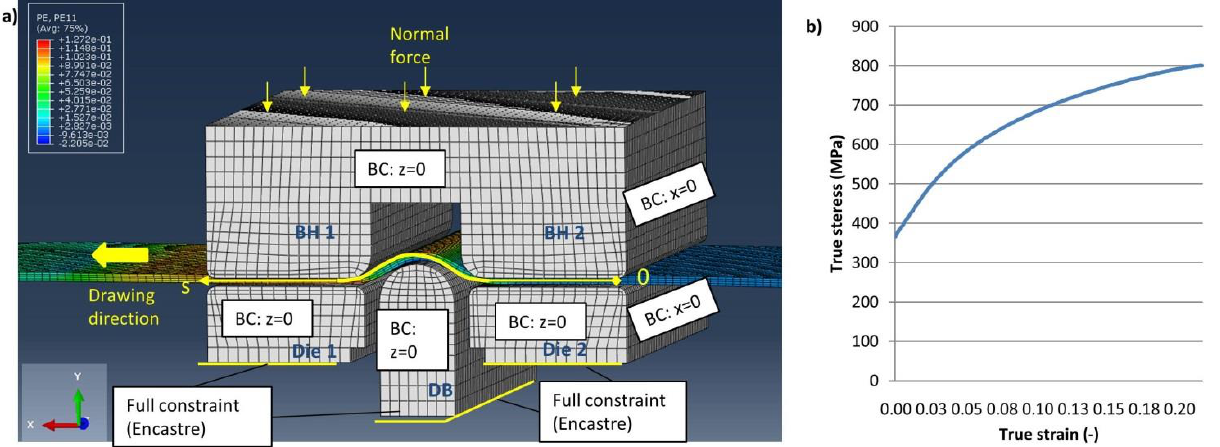
Figure 21. ( a ) Three-dimensional model for calculating the strain distribution in the wear test with draw bead geometry with boundary conditions (after drawing the sheet 40 mm in drawing direction); ( b ) flow stress of DP600 at room tem- perature.